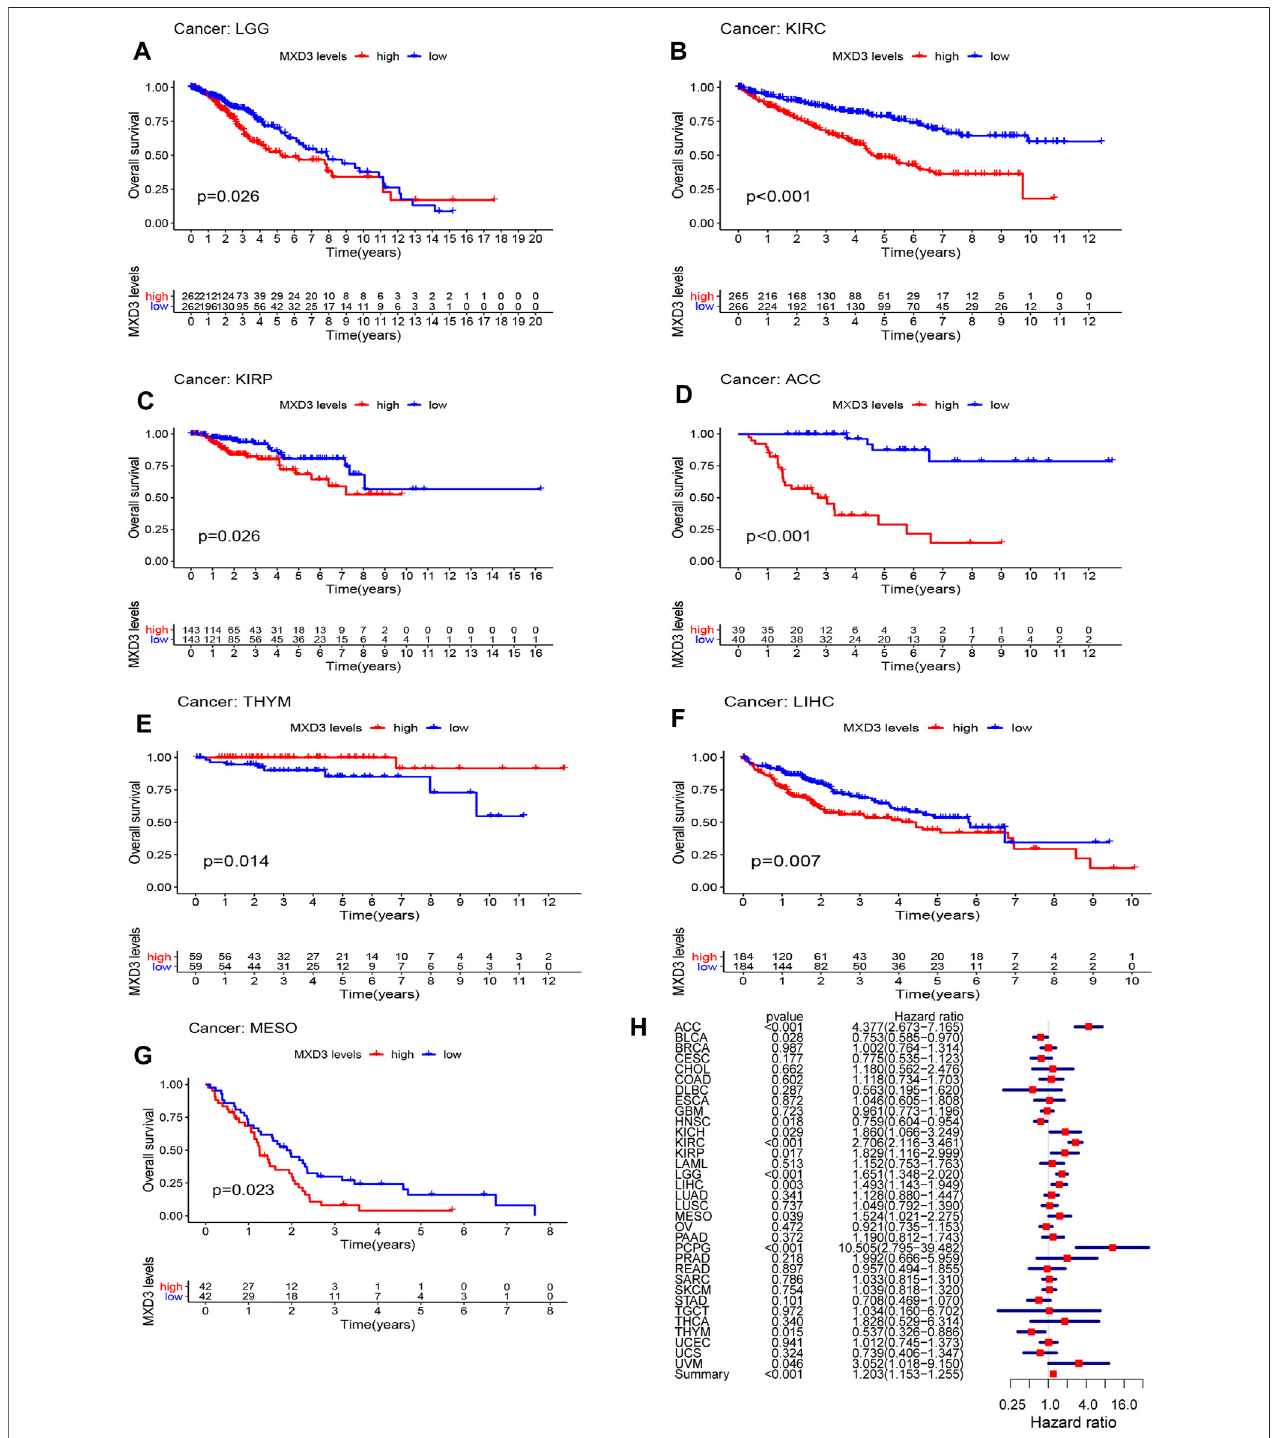
FIGURE2| OSwithdifferentMXD3expressioninLGG (A) ,KIRC (B) ,KIRP (C) ,ACC (D) ,THYM (E) ,LIHC (F) ,andMESO (G) .CoxregressionofMXD3andOS (H) in cancer types.